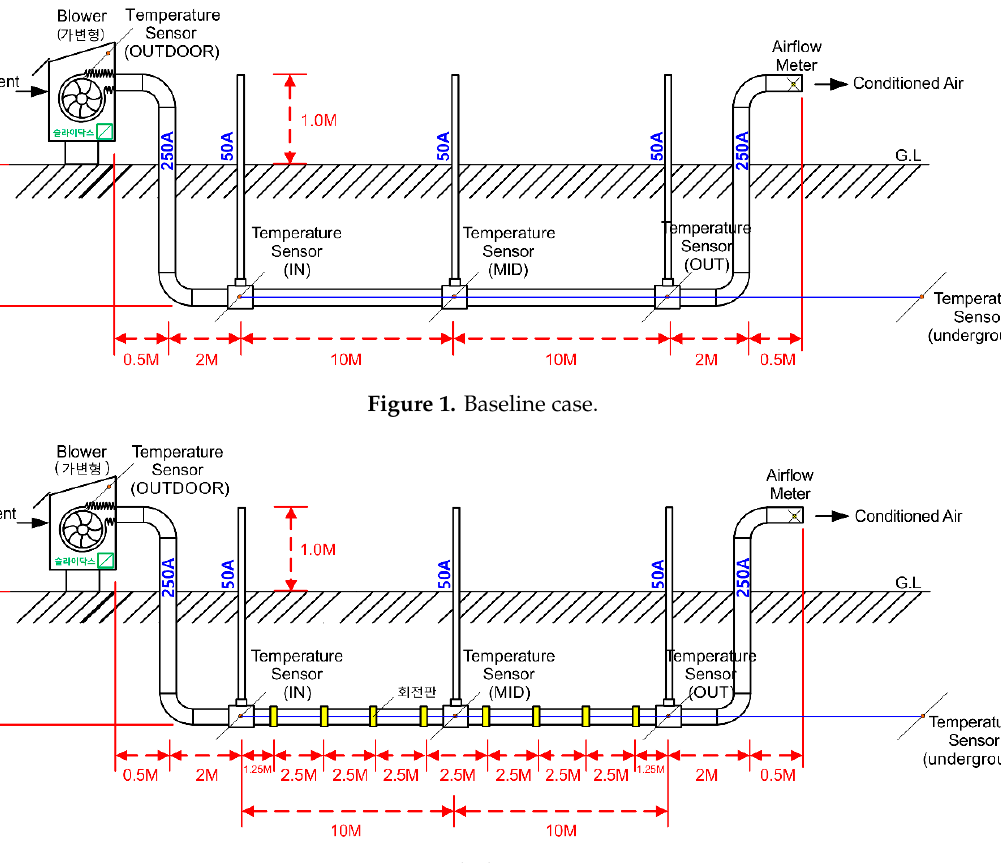
Figure 2. Turbulent insert case.